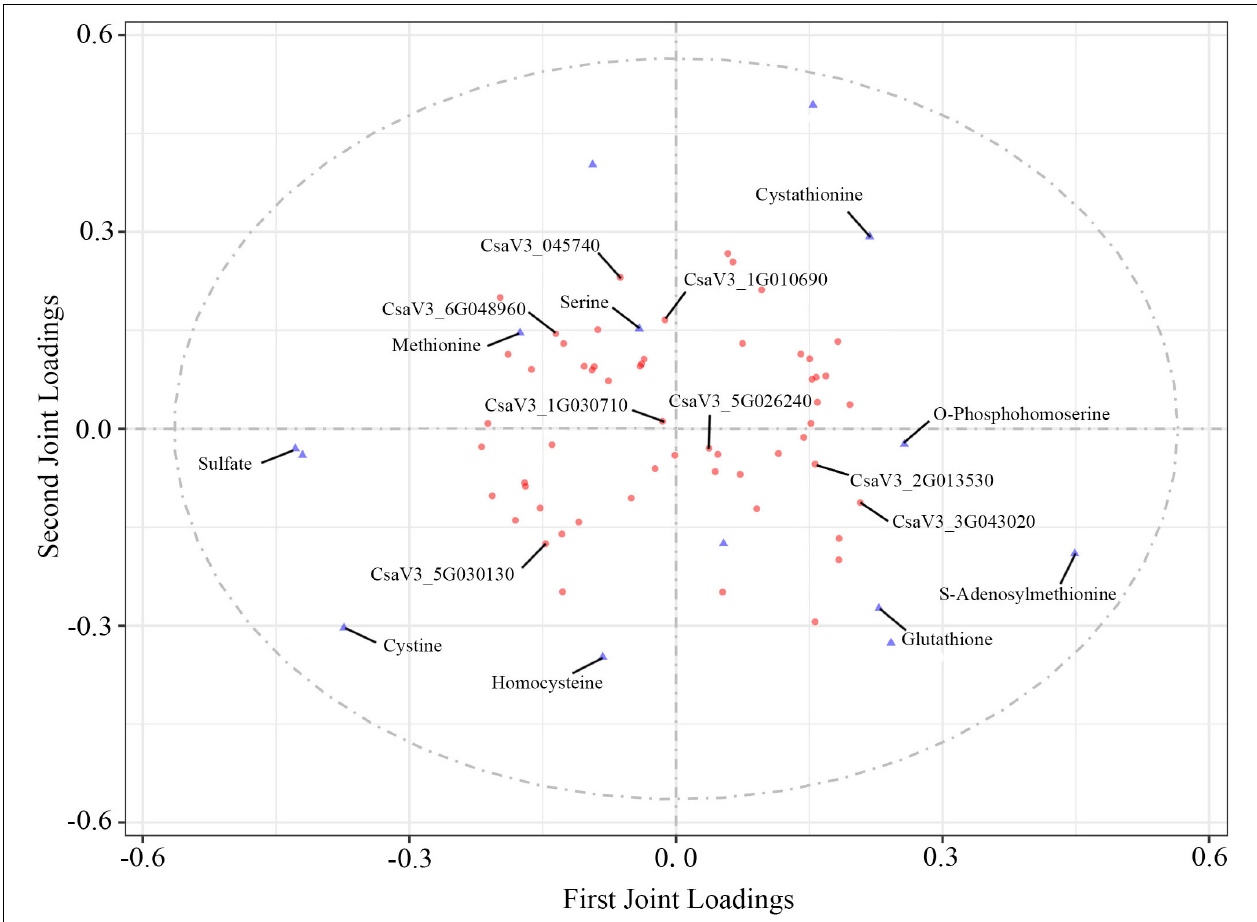
FIGURE 8 | O2PLS loading plot of metabolites and transcripts involved in S-related metabolism. Transcripts (circles) and metabolites (triangles) represent individual transcript and metabolite loading values, respectively ( Supplementary Tables 9 , 10